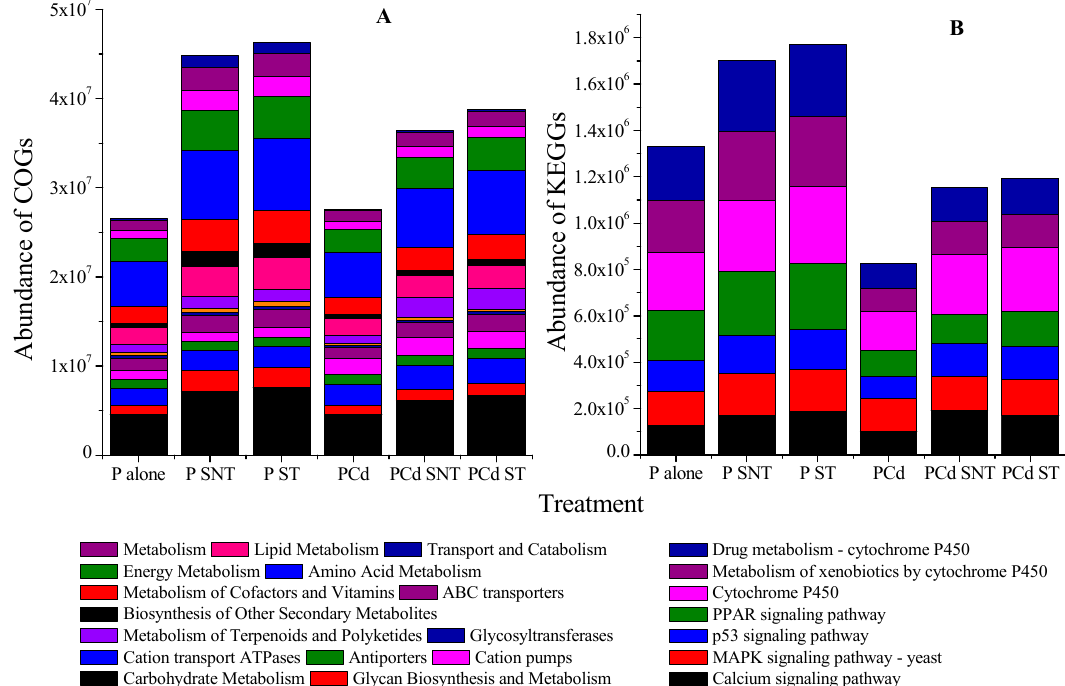
Figure 5. Effect of modified and unmodified rice straw on the distribution of Clusters Orthologous Groups (COGs) functional categories ( A ) and KEGGS metagenome functional prediction of the dataset (identified OTUs) ( B ).